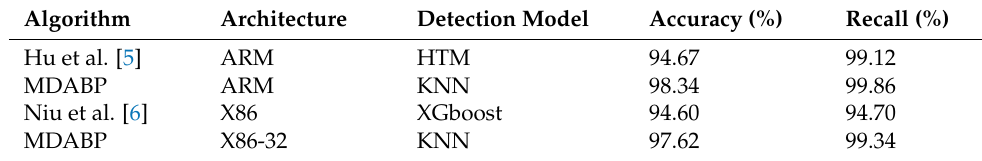
Table 2. Single CPU architecture performance.